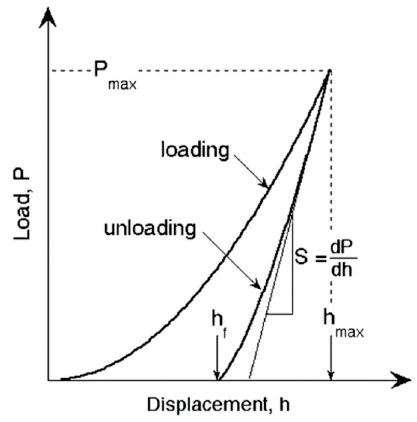
Figure 6. Schematic load-displacement diagram [27].